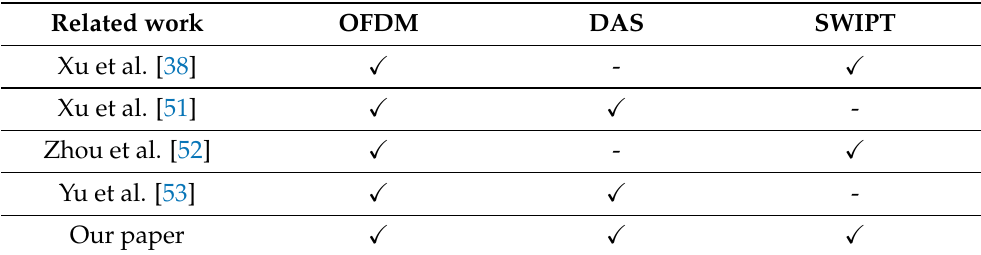
Table 3. Recent Power Allocation Schemes.